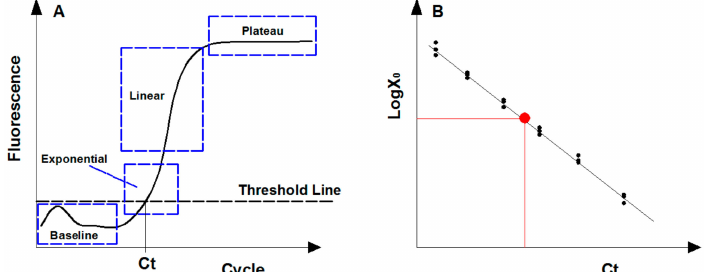
Figure 2. Description of real-time quantitative PCR assay. ( A ) Fluorescence signal levels in four qPCR amplification phases due to the consumption of reaction reagents. ( B ) Standard curve generated by plotting the cycle threshold (Ct) value of diluted standards. The red point represents the target sample that can be calculated following the standard